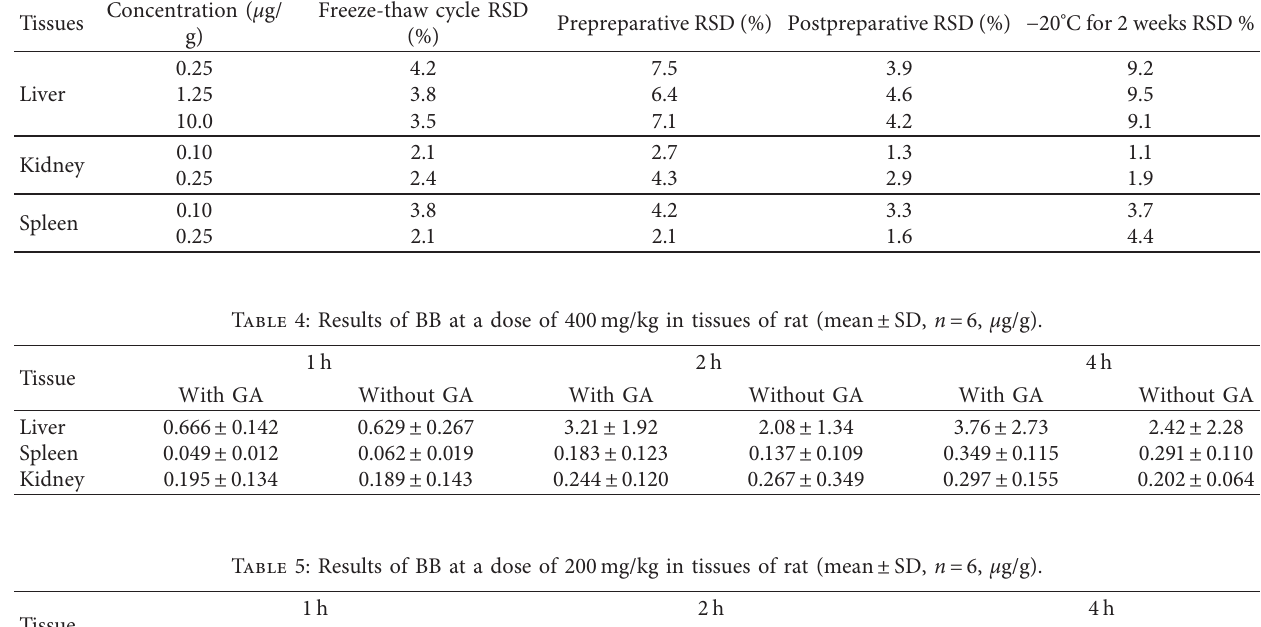
Table 3: Stability of BB in samples ( n � 3).